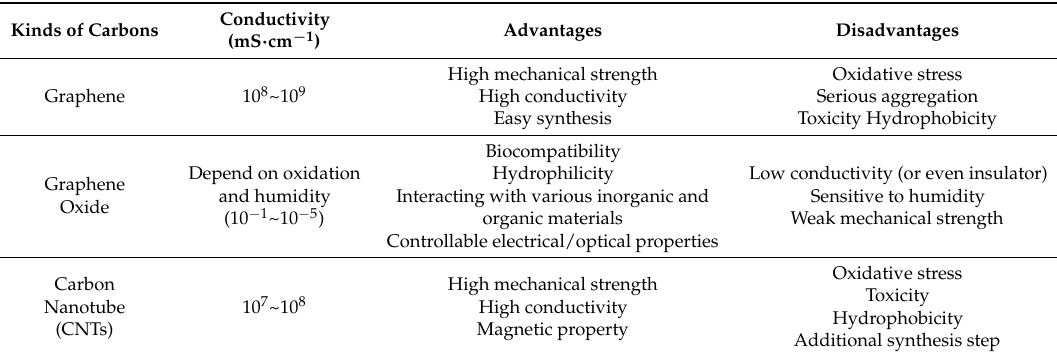
Table 3. Bulk Properties of Carbon